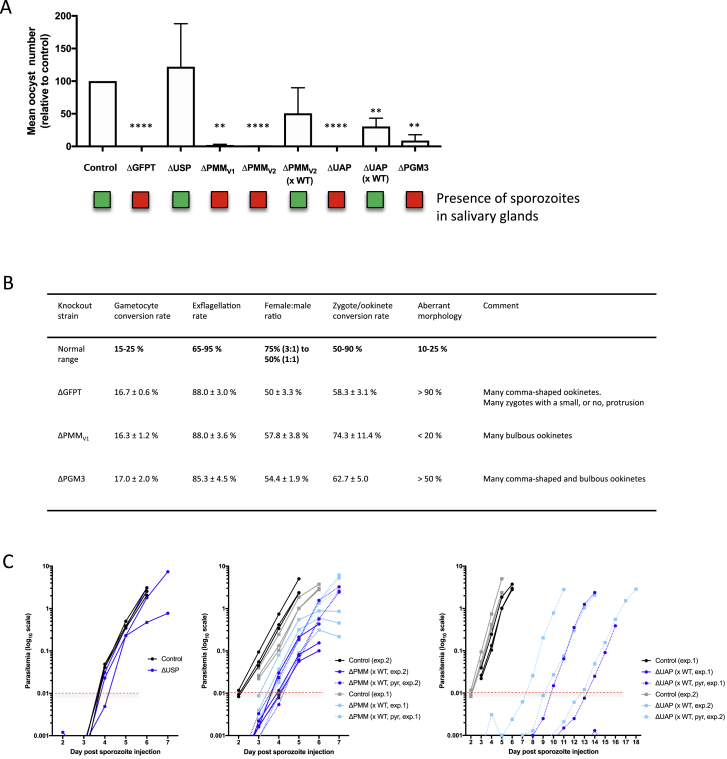
Phenotypic Analysis of Gene Knockout Mutant Parasite Lines Associated with the Amino Sugar Biosynthesis Pathway, Related to Figure 7(A) Graph showing oocyst numbers (relative to control; set to 100%) at day 7 post infection for ΔUSP, ΔPMMv1, ΔPMMv2, ΔPMMv2 (xWT), ΔUAP, ΔUAP (xWT) and ΔPGM3 parasites. Error bars indicate standard deviation. The results were statistically evaluated by a one-way analysis of variance (ANOVA) test with Dunnet’s multiple comparisons (∗∗p < 0.01, ∗∗∗p < 0.001, ∗∗∗∗p < 0.0001). Boxes shown below the graph indicate the presence (green) or absence (red) of sporozoites from the salivary glands for each knockout strain between days 18 and 21 post-infection. (B) Table displaying sexual and mosquito stage phenotypic data for ΔGFPT, ΔPMMv1 and ΔPGM3 parasites; gametocyte conversion rate, exflagellation rate, female: male ratio, zygote to ookinete conversion rate and percentage of ookinetes showing abnormal morphology. Data is shown in relation to normal ranges for such phenotypic assessments. (C) Graphs to show parasitemia for mice injected with ΔUSP parasites and ΔPMMv2 (xWT) and ΔUAP (xWT) parasites (based on FACS). Data from all mice (control and KOs) are shown for two independent experiments and lines are drawn for the relative light unit level or parasitemia considered as being the point at which a mouse has become positive.